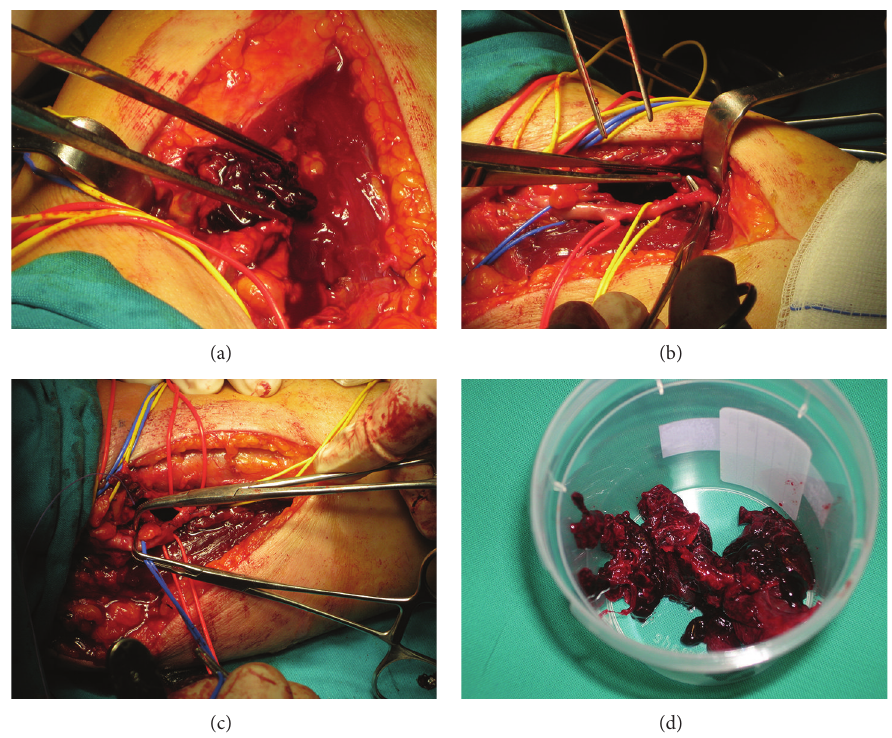
Figure 2: Consecutive phases of vascular intervention. (a) Clot detection immediately below muscular fascia; (b) isolation of vessels and recognition of multiple and point lacerations on the anterior and medial sides of radial artery; (c) radial arterial repair with application of 6-0 prolene sutures; (d) thrombus removed from periarterial